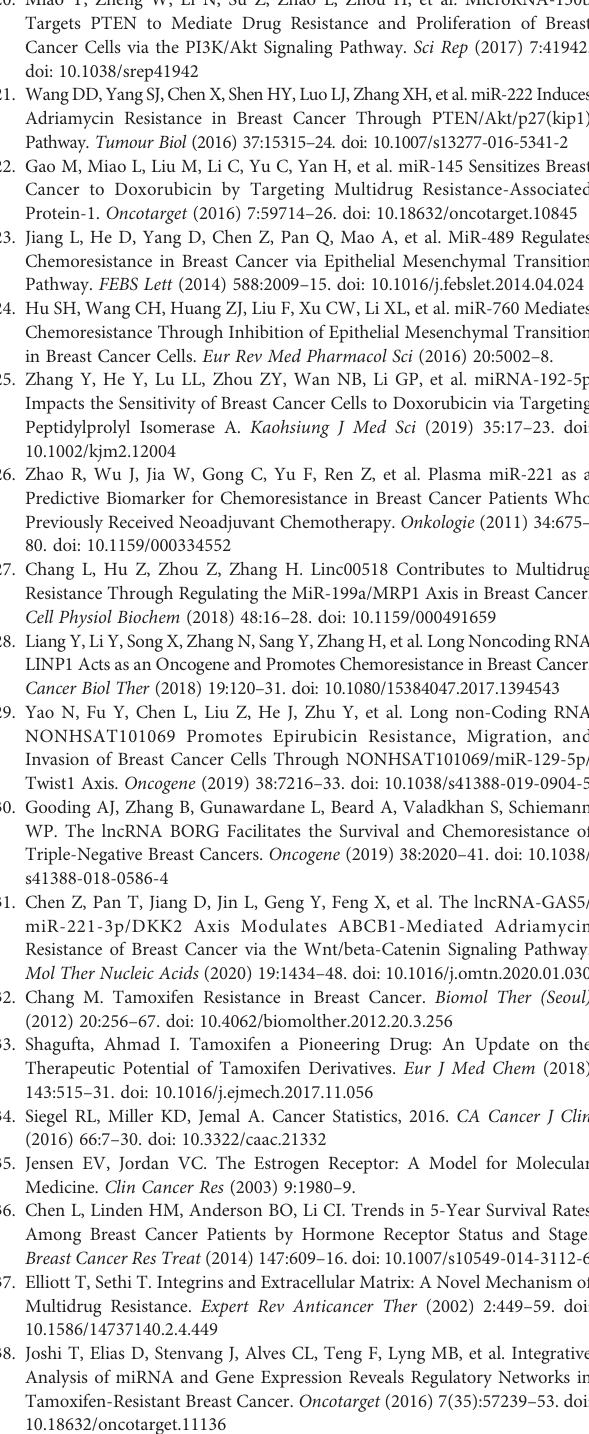
Supplementary Figure 3 | The pattern diagram of ncRNAs and Paclitaxel chemoresistance. Supplementary Figure 4 | The pattern diagram of ncRNAs and Docetaxel chemoresistance.